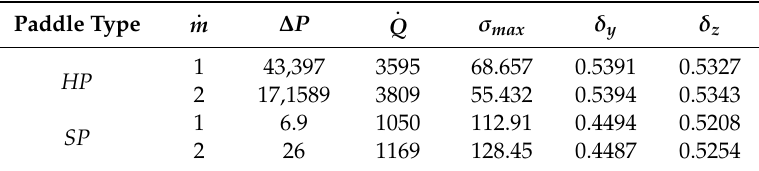
. m : h o = 250 W / (m 2 K), ∆ T = 100 ◦ C, H = 62 mm, d = 8 mm, φ = 0.53, Table 8. Two cases with di ff erent Table 8. Two cases with different m  : h o = 250 W/(m 2 K), Δ T = 100 °C , H = 62 mm, d = 8 mm, ϕ = 0.53, m = 2. m = 2.